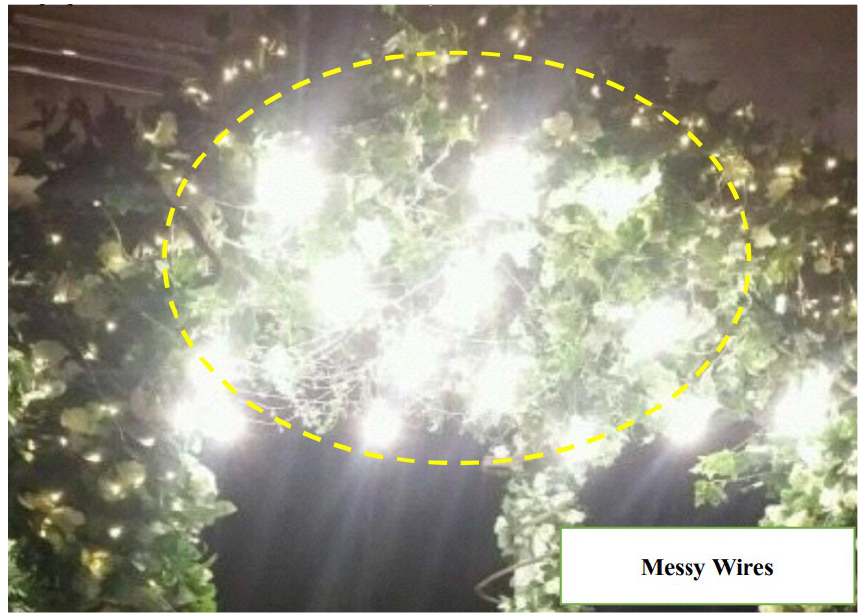
Figure 4. Electrical fires: Messy Wires on Photography base roof (picture source: [19]).